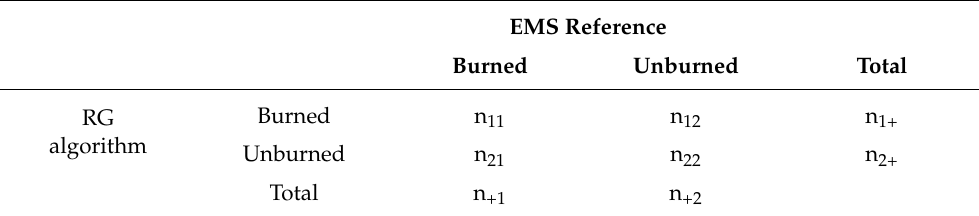
Table 3. Sampled error/confusion matrix: n ij express the number of pixels of agreements (diagonal cells) or disagreements (off diagonal cells) between the BA product and the reference EMS. In the case of binary classification (burned areas and not burned areas), considering as target objective of the algorithm the identification of burned areas, we can make this equivalence: True Positives (TP = n 11 ), True Negatives (TN = N 22 ), False Positives (FP = n 12 ) and False Negatives (FN = n 21 ). EMS Reference Burned Unburned Total Burned n 11 n 12 n 1+ RG algorithm Unburned